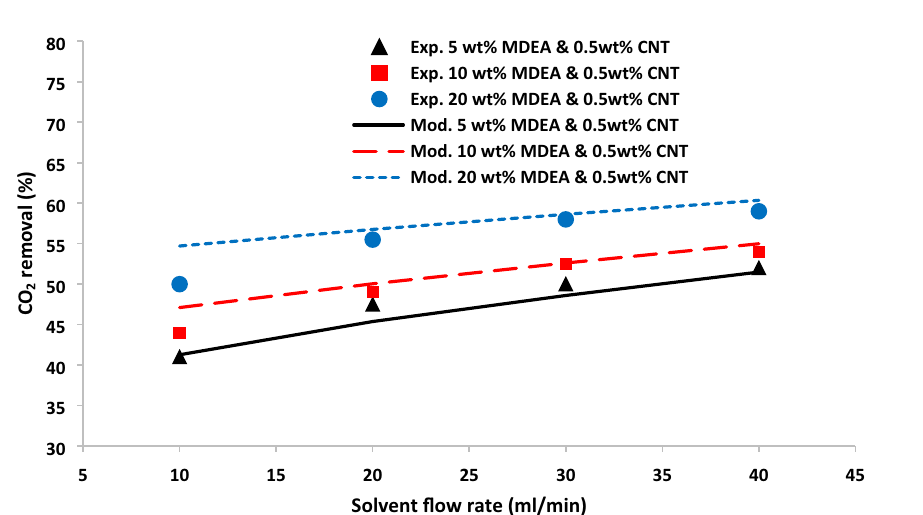
Figure 4. CO 2 removal % as a function of solvent flow rate with 0.5 wt% CNT NPs at different MDEA concentration at 10 ml/min gas flow